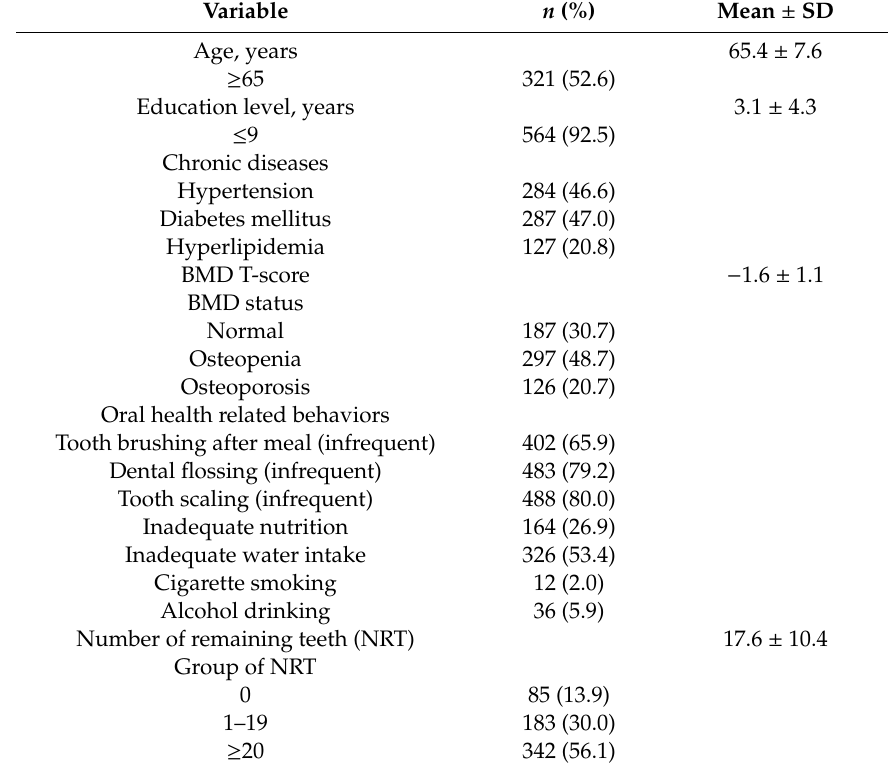
Table 1. Demographic characteristics of the participants ( N = 610).